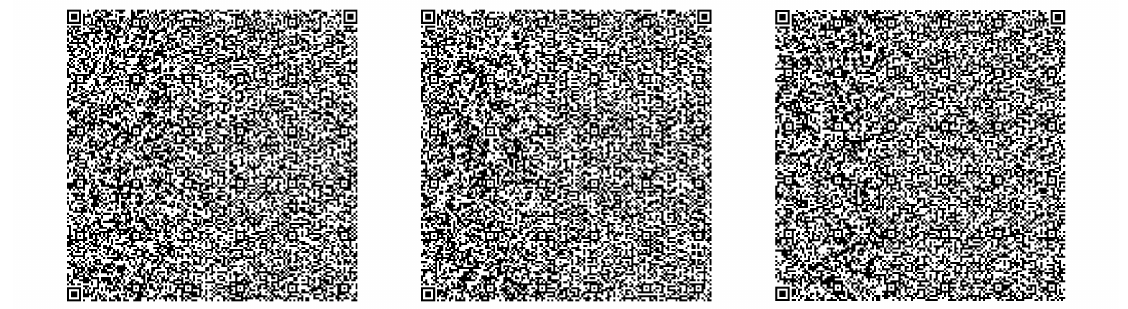
Figure A3. QR codes with the positions ( x , y ) and excitations ( a ) of the radiators for the 346 elements sparse